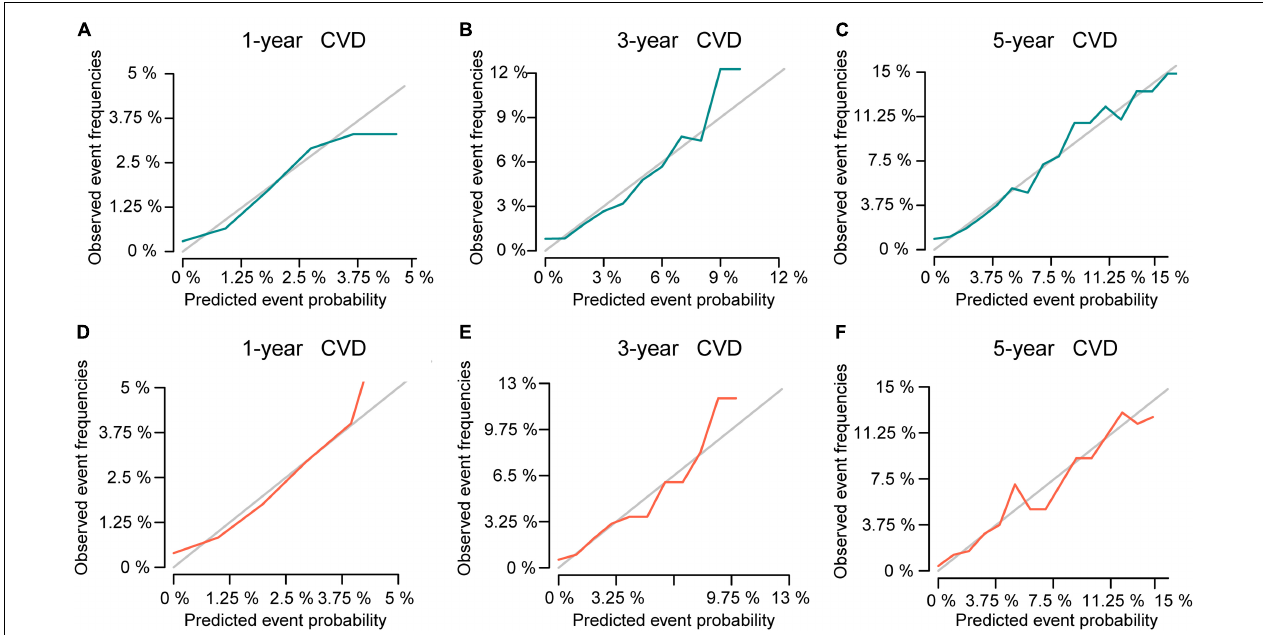
FIGURE 4 | The calibration curve for predicting the 1-, 3-, and 5-year probabilities of CVD in the training (A–C) and the validation cohort (D–F) , respectively.